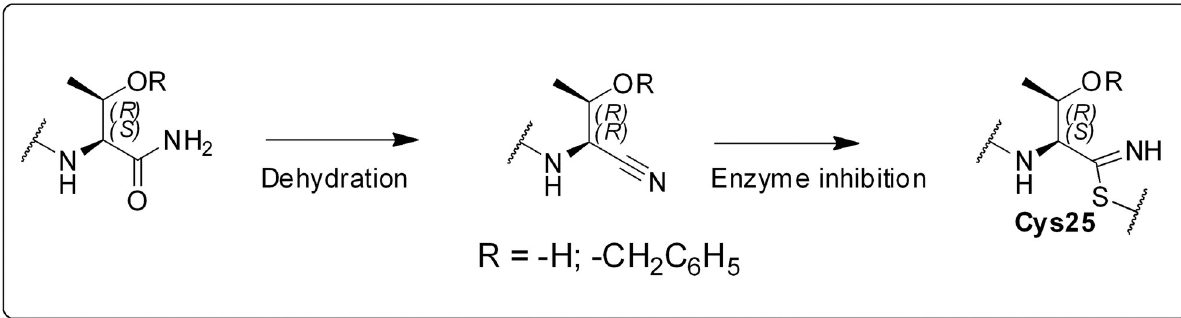
Fig 7. Change in stereochemistry for compounds bearing Thr or Thr-O-Bzl group in P1.